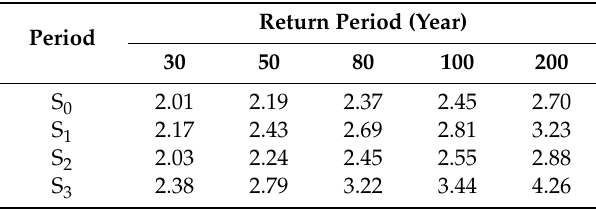
Table 3. Averaged I t according to the analysis periods and return periods.